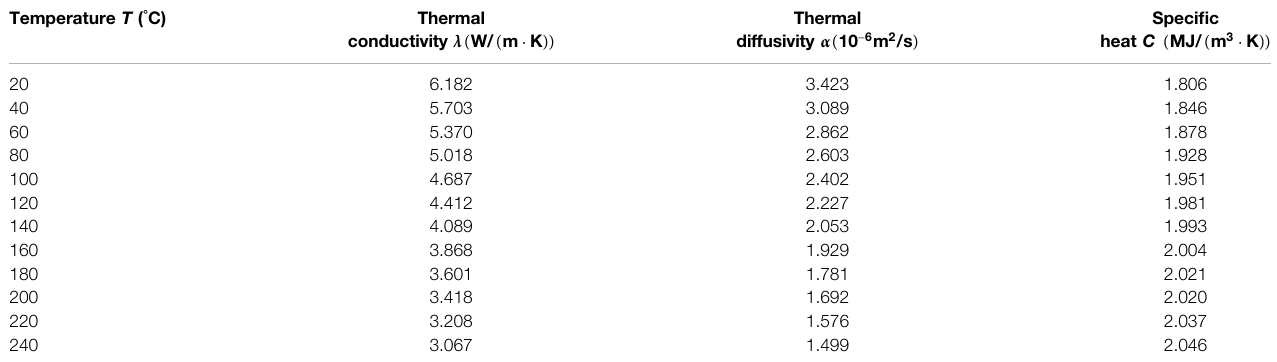
TABLE 2 | Test results of thermal parameters of NaCl single crystal.